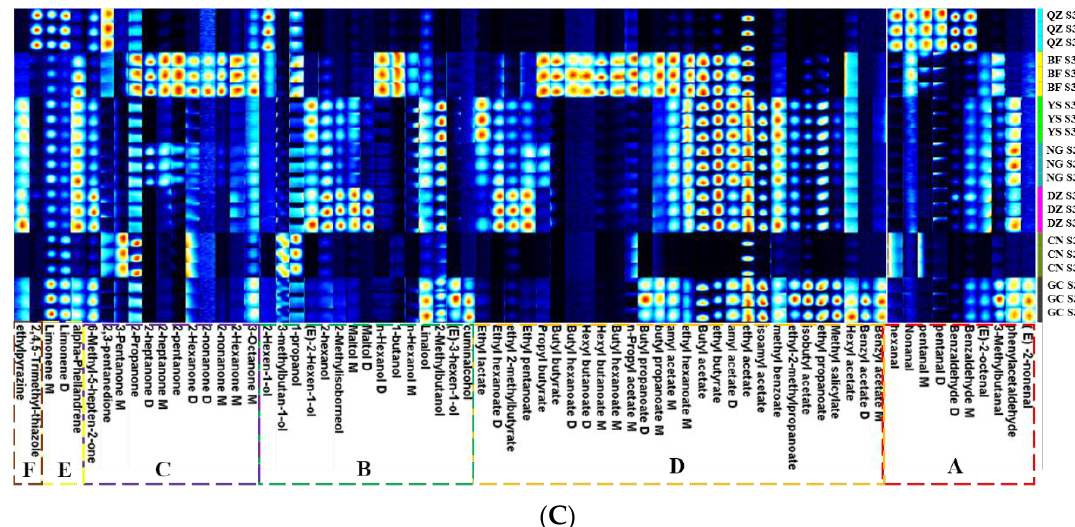
Figure 3. The VOC fingerprints of different green plum varieties of the same maturity: ( A ) S1 stages of green plum samples of 7 varieties; ( B ) S2 stages of green plum samples of 7 varieties; ( C ) S3 stages of green plum samples of 7 varieties.